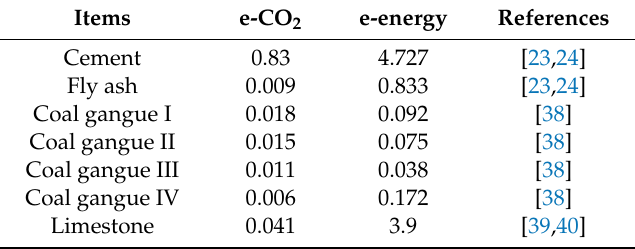
Table 3. Embodied carbon dioxide (e-CO 2 ) and embodied energy of the raw materials in